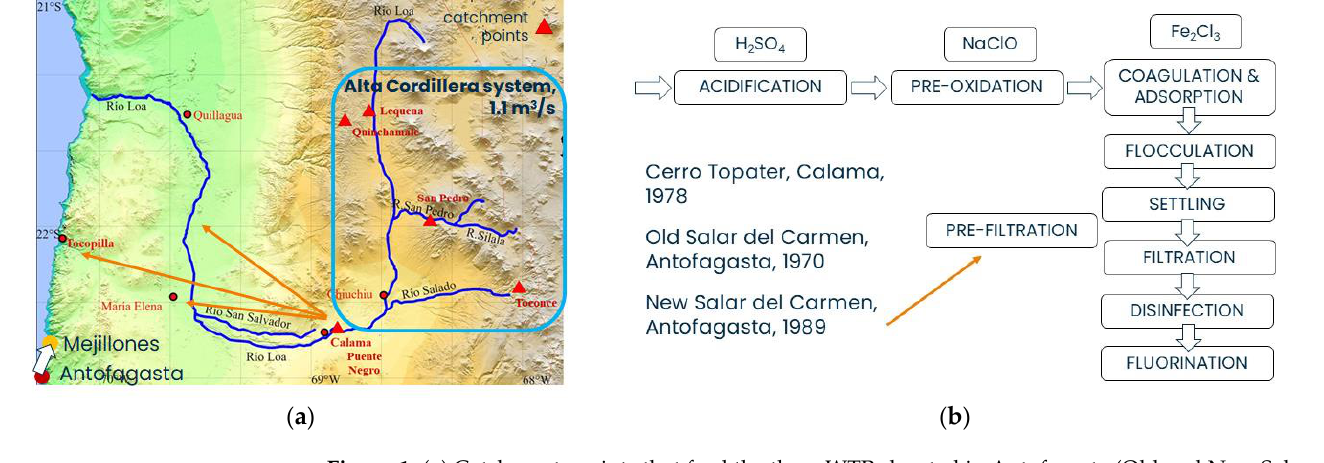
Figure 1. ( a ) Catchments points that feed the three WTPs located in Antofagasta (Old and New Salar del Carmen) and Calama (Cerro Topater); ( b ) Scheme of the treatment train of the three WTPs. Table 1 displays the quality of the waters coming from the five catchment points The Alta Cordillera system, through its four water sources, provides an average flow [34,35]. rate of 1.1 m 3 /s.